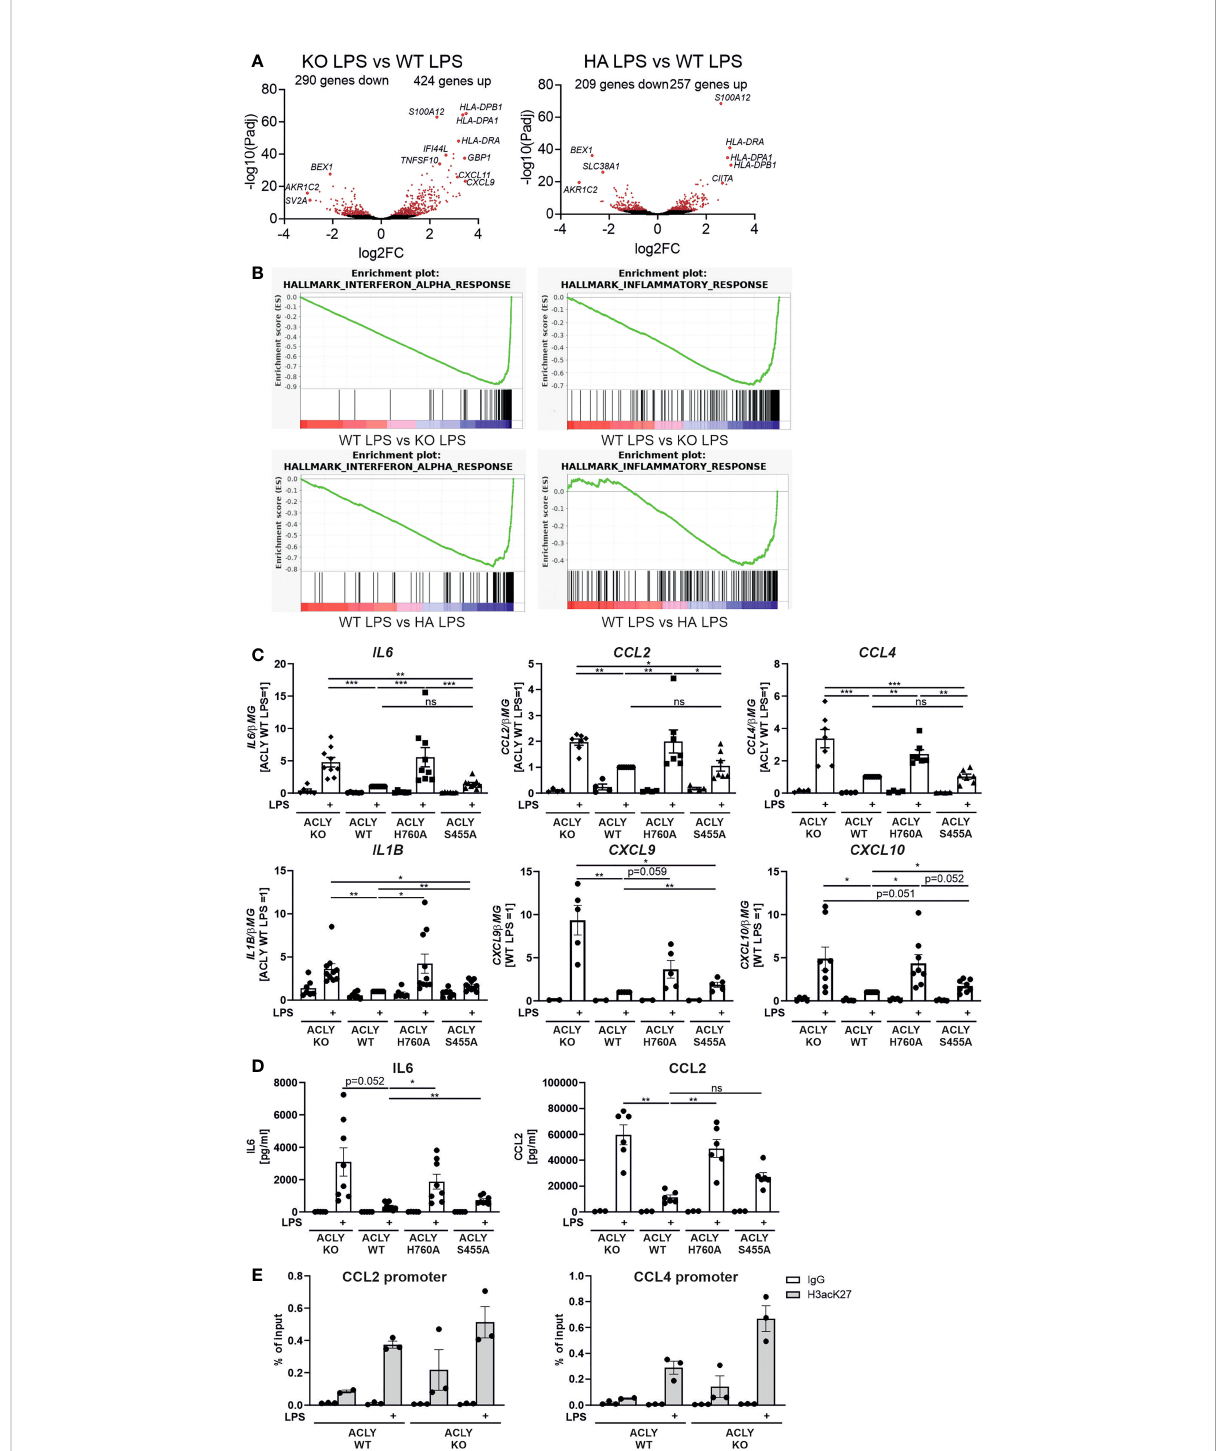
FIGURE 2 ACLY knockout enhances pro-in fl ammatory gene expression in THP-1 cells. (A) Volcano plot of differentially expressed genes in ACLY knockout vs WT or H760A vs WT THP-1 cells treated with 100 ng/ml LPS for 3 hours. (B) GSEA enrichment plots for indicated gene sets comparing LPS- stimulated ACLY knockout vs WT or H760A vs WT THP-1 cells. (C) mRNA expression of indicated genes in ACLY knockout, WT, H760A and S455A THP-1 cells treated with 100 ng/ml LPS for 3 hours. (D) Secretion of IL6 and CCL2 by WT, H760A and S455A THP-1 cells treated with 100 ng/ml LPS for 24 hours. (E) Association of K27-acetylated histone H3 with promoters of CCL2 and CCL4 genes analyzed by ChIP. Data represent mean values ± SE of 3-9 independent experiments. * p<0.05, ** p<0.01, *** p<0.001, ns, non signi fi